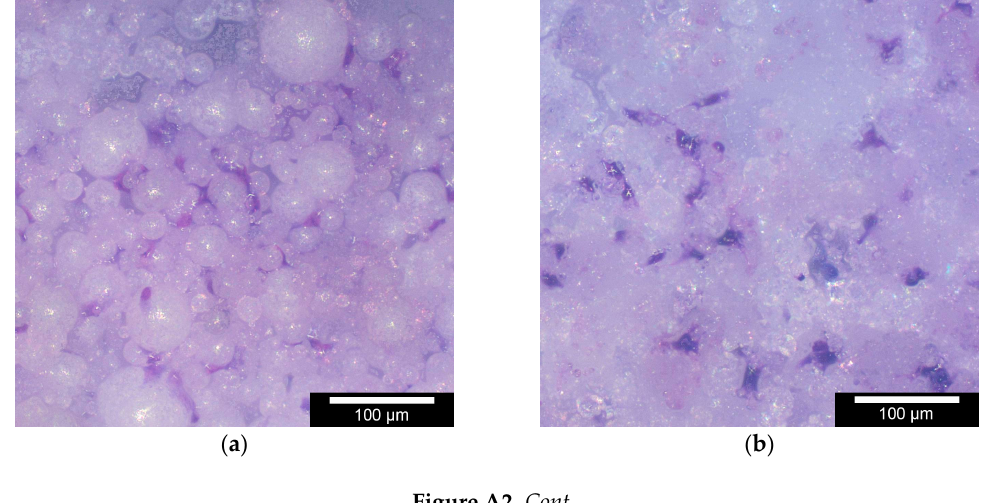
( d ) Figure A2. Giemsa Staining of MG63 cells on the Scaffolds after 24 h: ( a ) BG; ( b ) TCP; ( c ) 50/50; and ( d ) 70/30: Images taken with Olympus BX 51 with reflected light in 10× magnification. The staining was according to the protocol given in Romeis [43].